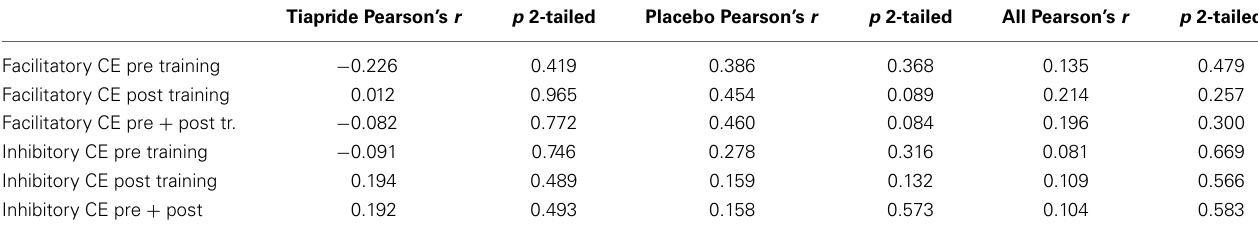
relation between reproduction (x) and improvisation (y) performance in the placebo (diamond) and tiapride (triangle) group. The dashed line rectangle frames the data points of those six placebo and two tiapride participants with both good reproduction and good improvisation ( > 50%).